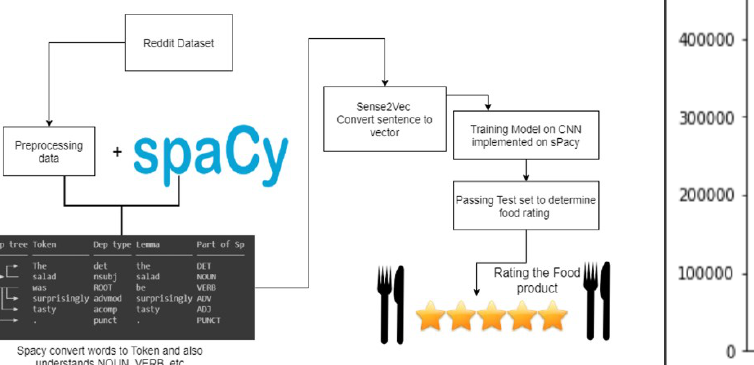
Fig. 4 Histogram plot on data set